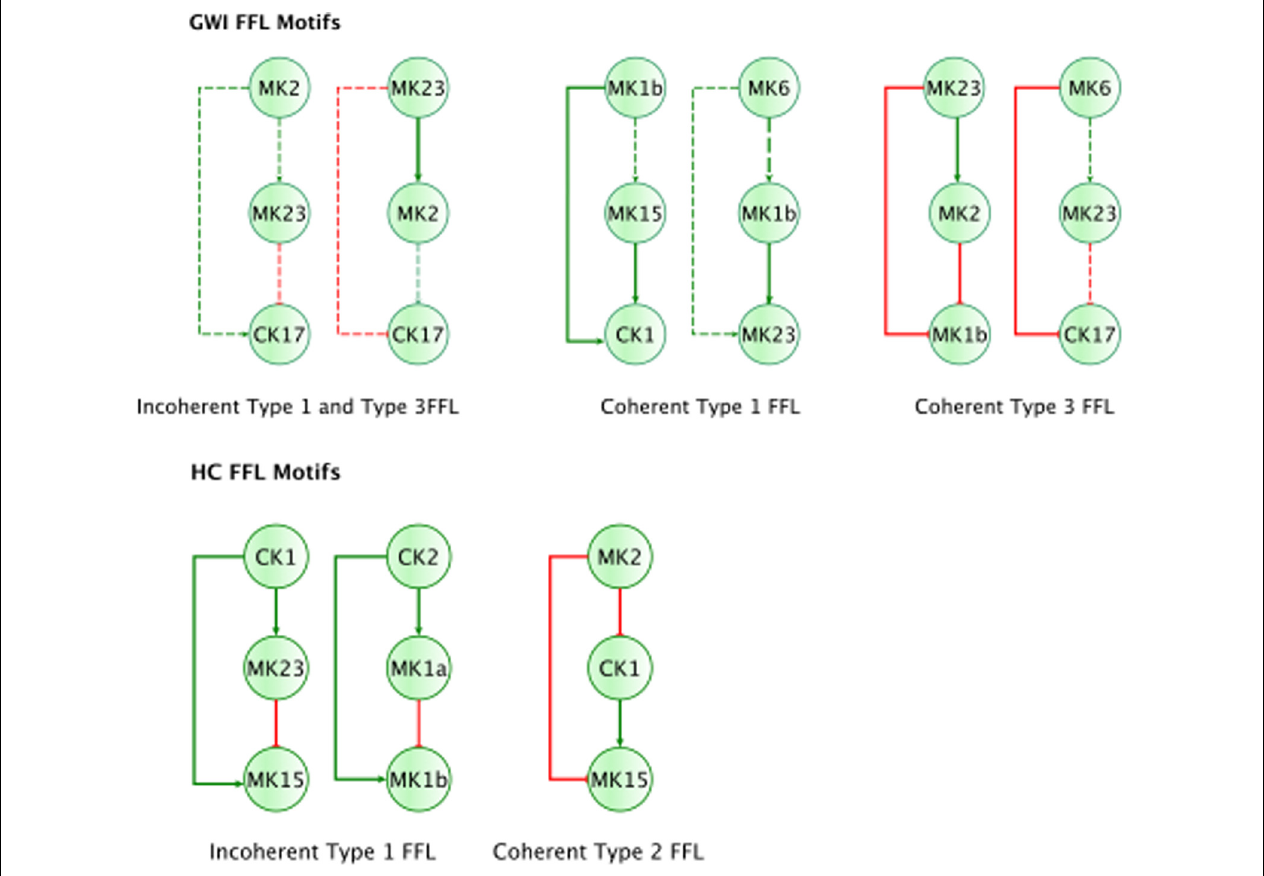
FIGURE 4 | Basic regulatory control motifs in HC and GWI. Minimal regulatory component feedforward control motifs suggested by Alon (2007; Milo et al., 2002) emerge as unique features in the sub-circuits for each illness group. Specifically, coherent feedforward loops (FFL) type 1 and 2 unique to HC (A–C), indicating robustness to sudden disturbances. The GWI circuit however presents with the incoherent type 1 FFL (D), associated with bi-modal